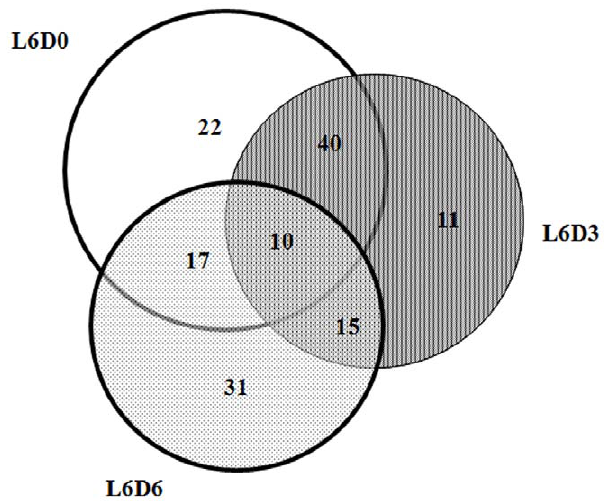
Figure 1. Distribution of ‘‘no-hits’’ assembled ESTs in the three cDNA libraries. L6D0 was a molting phase of 5 th instar to 6 th instar larvae that did not feed. During this phase, the midgut structure was undergoing remodeling. L6D3 was a larval growth and feeding stage, during which the midgut was actively participating in food digestion and nutrient absorption. L6D6 was a prepupal stage, at which the larvae were not feeding and the midguts were preparing remodeling and transformation from larval to pupal structures.